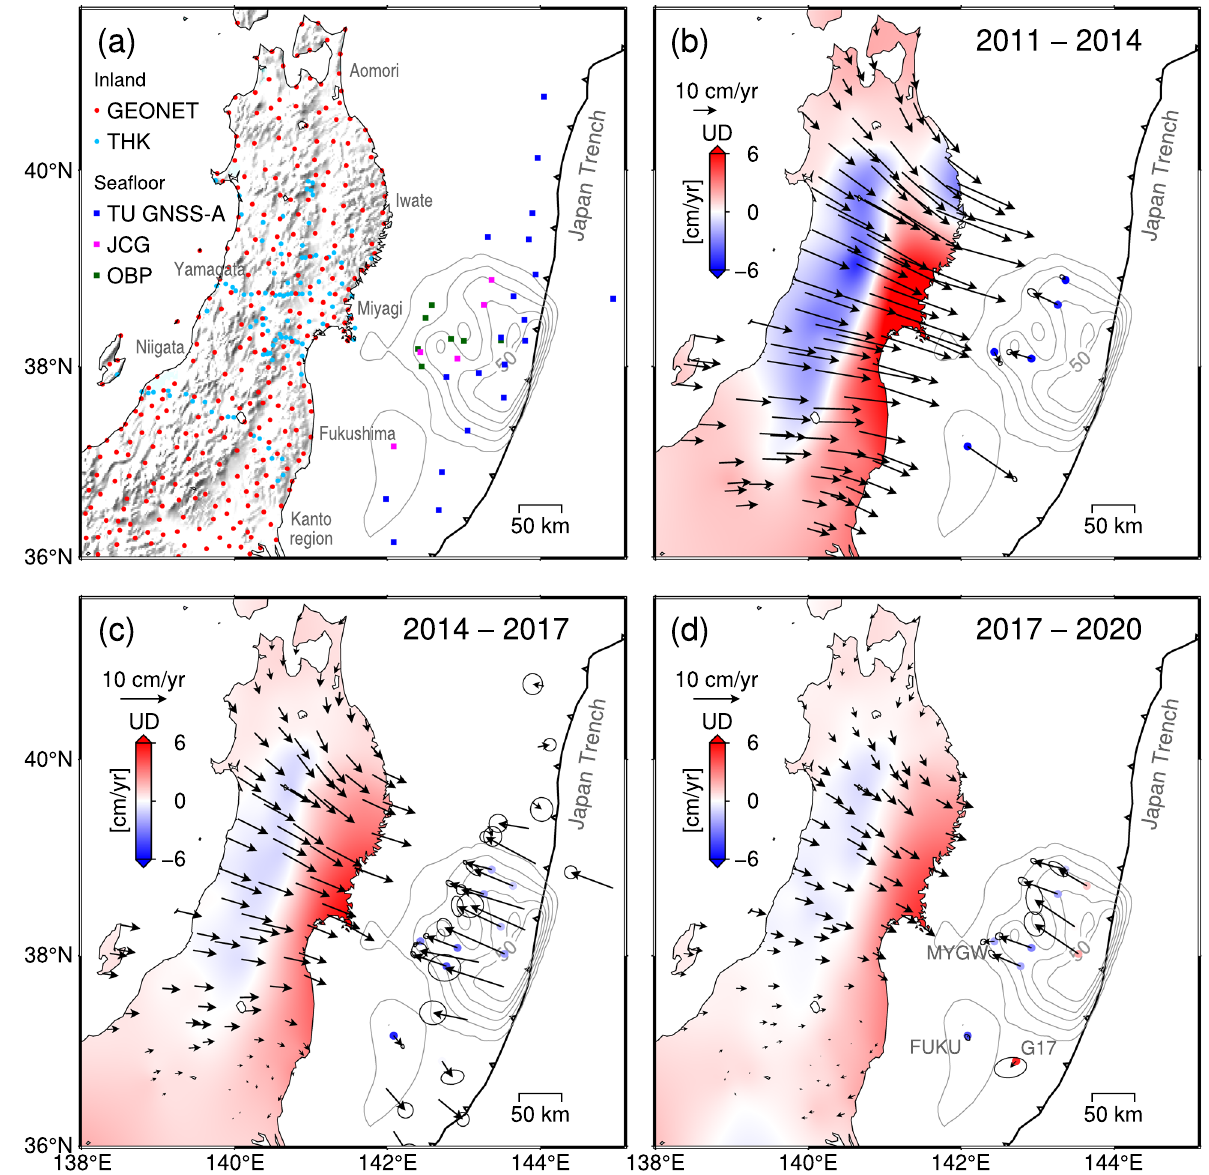
Fig. 2 Decade-long geodetic observations after the 2011 Tohoku-oki earthquake around NE Japan. a The location of onshore and offshore geodetic stations. b Displacement rate during April 2011–April 2014, c April 2014–April 2017, and d April 2017–April 2020. Note that only high-quality data of 110 GEONET stations is plotted and horizontal motion during 2011–2014 is scale down to one half in ( b ). The displacement rate at JCG and TU GNSS-A sites is opted from Honsho et al. (2019) and Watanabe et al. (2021). The displacements of inland GNSS stations are referenced to Fukue station (ID: 950,462; 128.843°E,